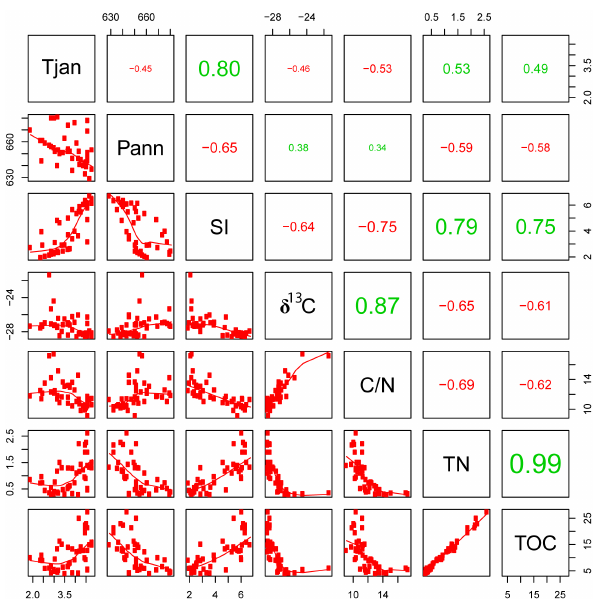
Figure 7. Pairwise correlation between the three climatic variables ( T jan , P ann , and SI) and the chemical elements.